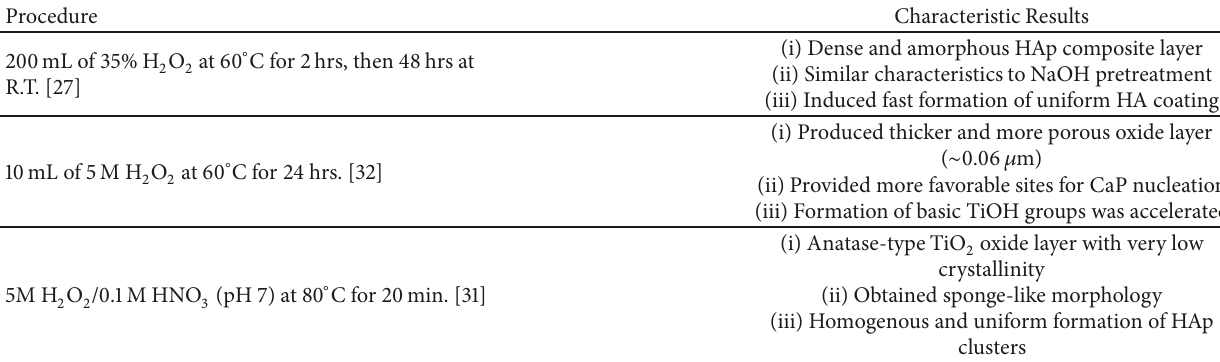
Table 1: Surface properties obtained from immersing Ti substrates in various H 2 O 2